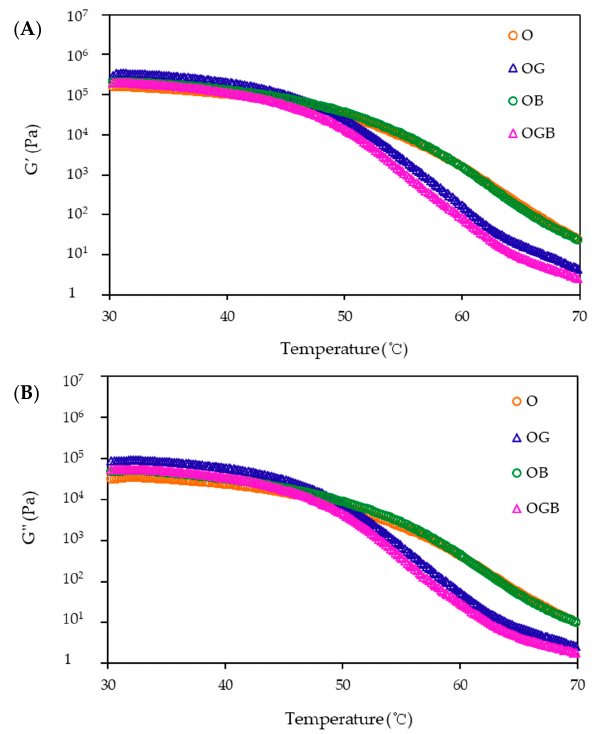
Figure 3. Viscoelastic changes of oleogels over temperature: ( A ) storage moduli and ( B ) loss moduli (O: oleogel, OG: oleogel + GMS, OB: oleogel + β -carotene, OGB: oleogel + GMS + β -carotene).